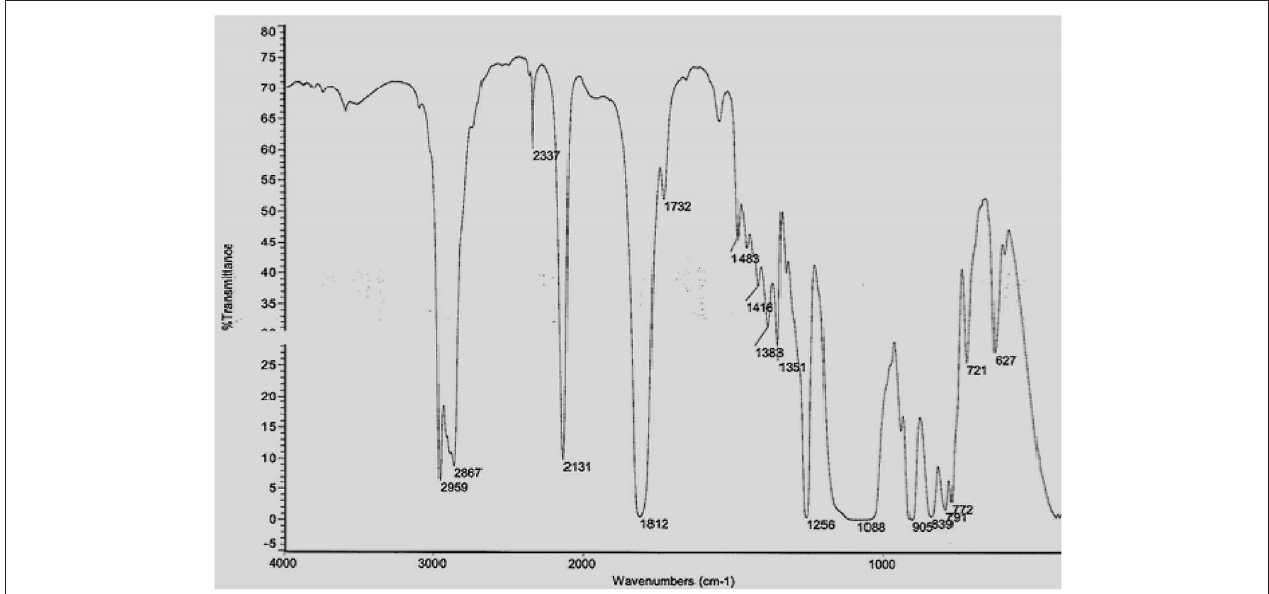
FIGURE 2 | FTIR spectrum of carbonate terminated HBP5 (neat).